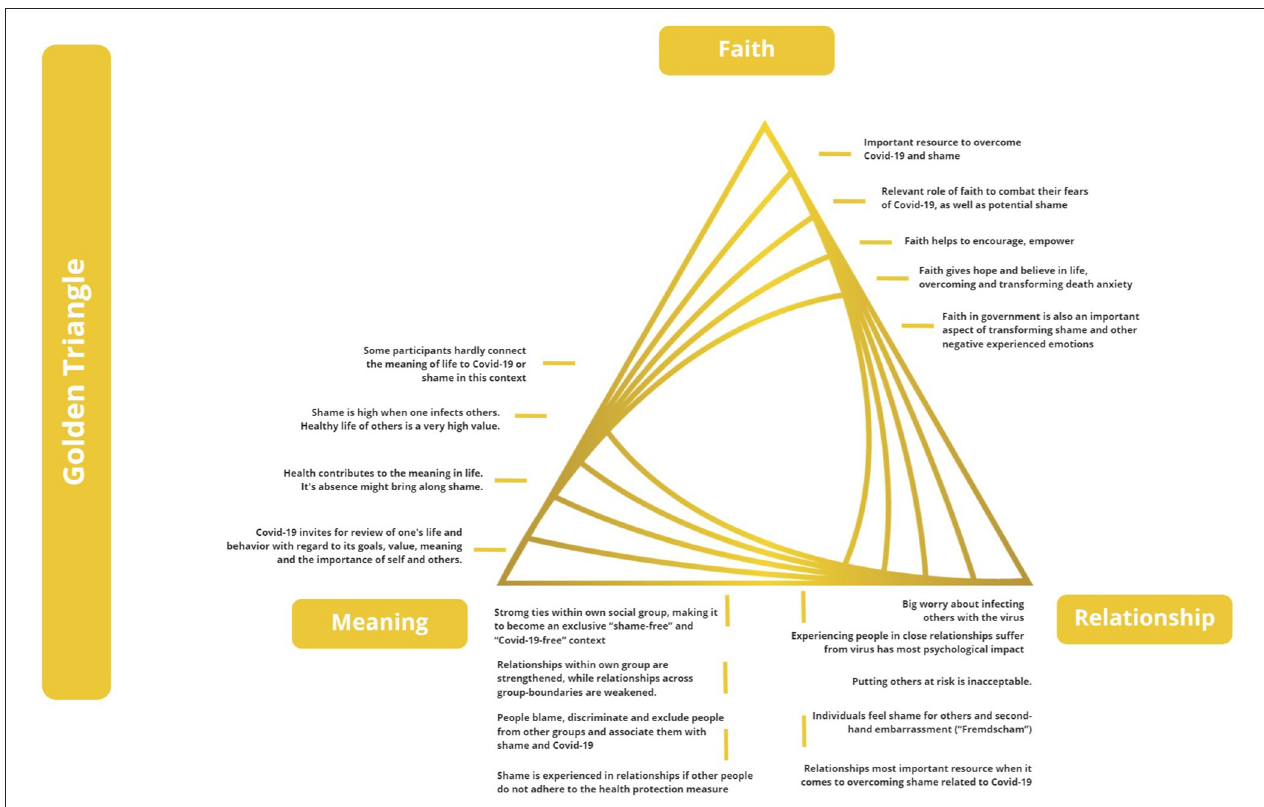
FIGURE 3 | Findings with regard to the Golden Triangle, based on Wong (2019).